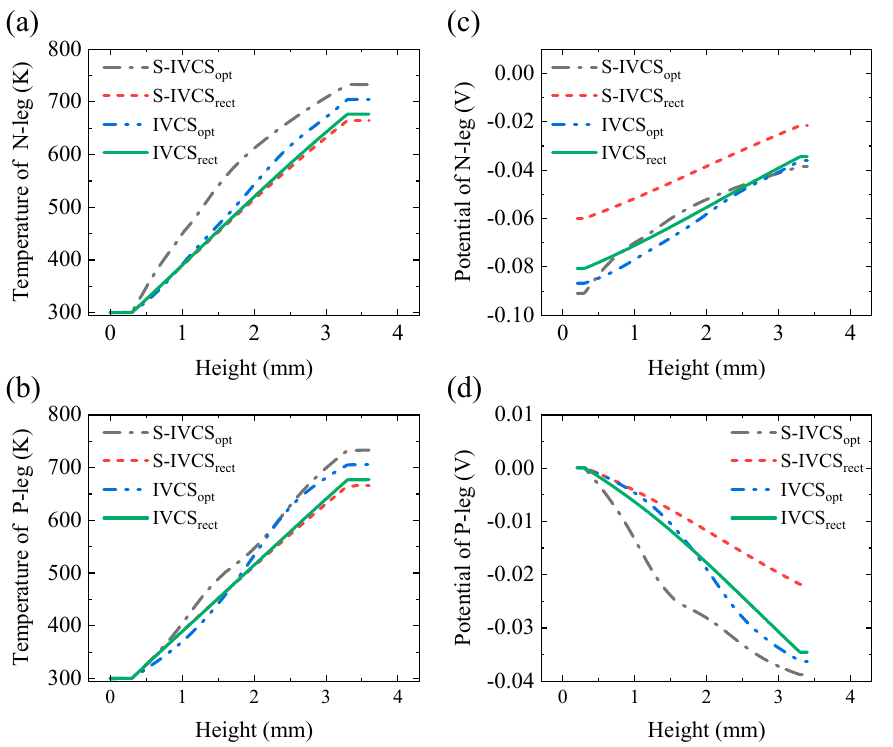
Figure 13. Temperature and electric potential distribution comparison between the four designs: ( a ) temperature of N-leg; ( b ) temperature of P-leg; ( c ) potential of N-leg; ( d ) potential of P-leg.